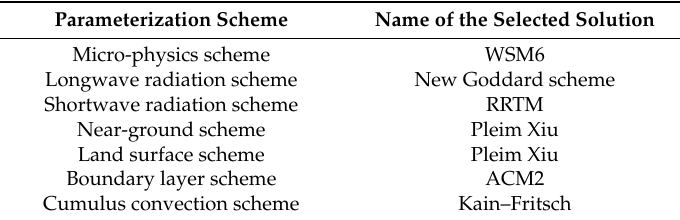
Table 3. WRF parameterization scheme.